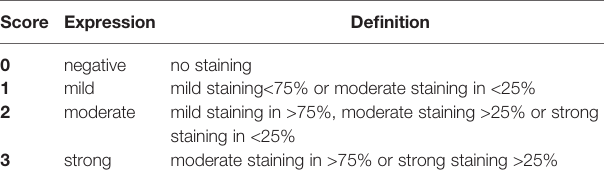
TABLE 2 | Four-point scale used in scoring IHC